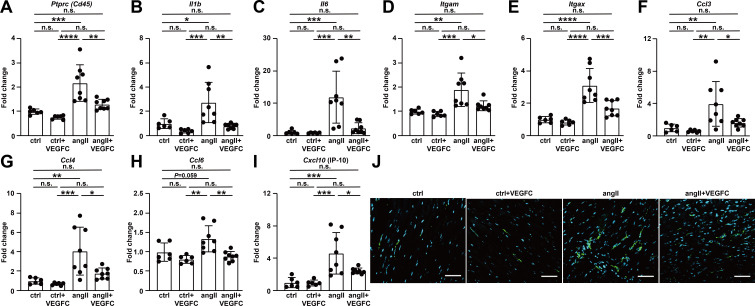
VEGFCC156S treatment reduced the gene expression of inflammatory markers in heart and alleviated cardiac inflammation at 1 week after treatment.(A–I) RNA was isolated from the mouse hearts, and quantitative RT-PCR was performed for Ptprc(Cd45) (A), Il1b (B), Il6 (C), Itgam (D), Itgax (E), Ccl3 (F), Ccl4 (G), Ccl6 (H), Cxcl10(IP-10) (I), and normalized to the expression of housekeeping gene Hprt. The data were normalized to ctrl group and represented as fold change (n = 6–8/group). (J) Mouse hearts were fixed, OCT embedded, sectioned, and stained for CD68 (green) and DAPI (light blue). Representative images for each group are shown. Scale bar, 50 μm. Ctrl, control. AngII, angiotensin II. VEGFC, VEGFCc156s. Data are mean ± s.d. One-way ANOVA with Bonferroni posthoc was used for statistics. *p<0.05, **p<0.01, ***p<0.001, ****p<0.0001, n.s. not significant.